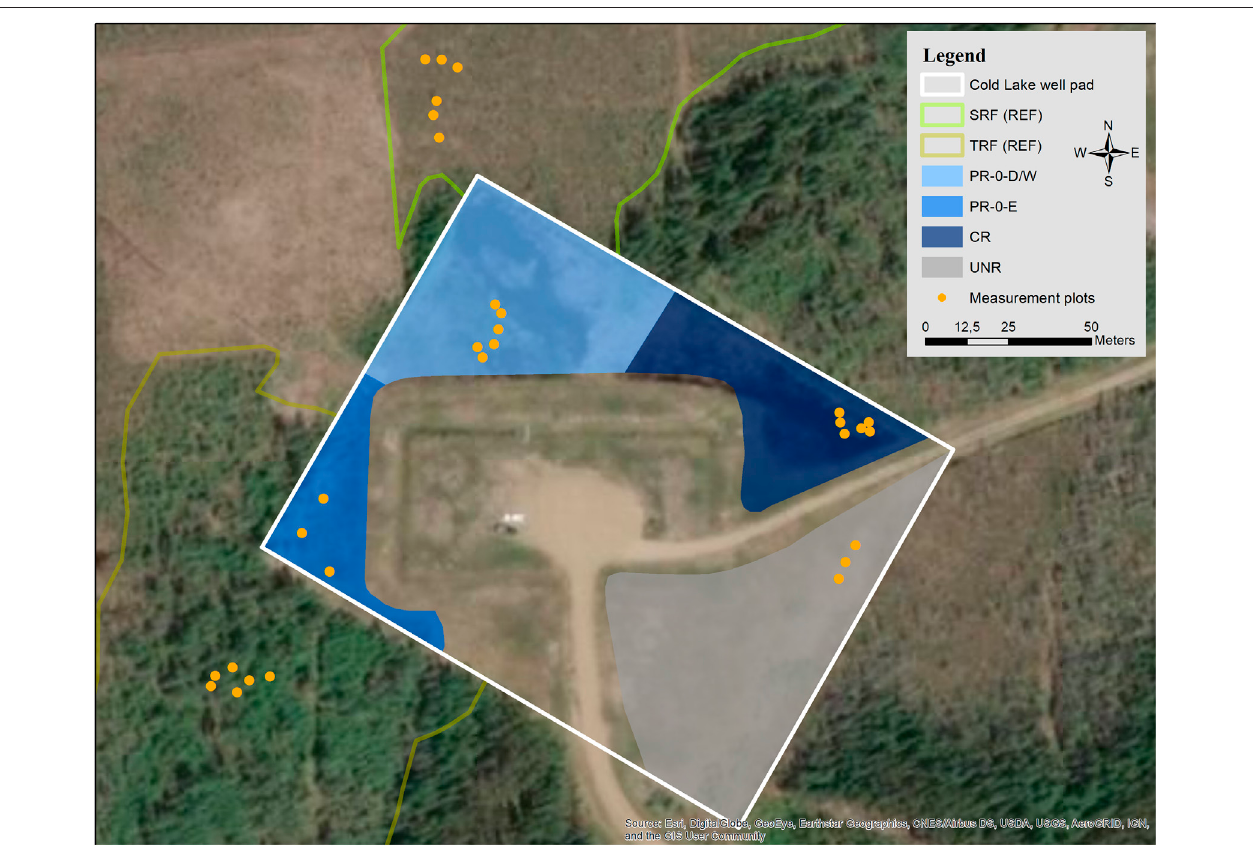
FIGURE 3 | The Cold Lake well pad (white outline) is located within a mosaic of uplands and wetlands, which serve as reference ecosystems (TRF (cid:2) treed rich fen, SRF (cid:2) shrubbyextreme-richfen).Blueshadedsectorsarerestored areaswheredifferentrestorationtechniquesofcompleteandpartialmineralsoilremovalweretested (CR (cid:2) completeremoval,PR-0-D/WandPR-0-E (cid:2) partialremovalofmineralsoiltoneartheadjacentfenecosystems,withhigh/dry(D)andlow/wet(W)microforms,and with even ground (E)). The gray shaded unrestored sector (UNR) serves as a control sector on the former well pad ’ s residual mineral soil. Yellow dots indicate measurement plots.